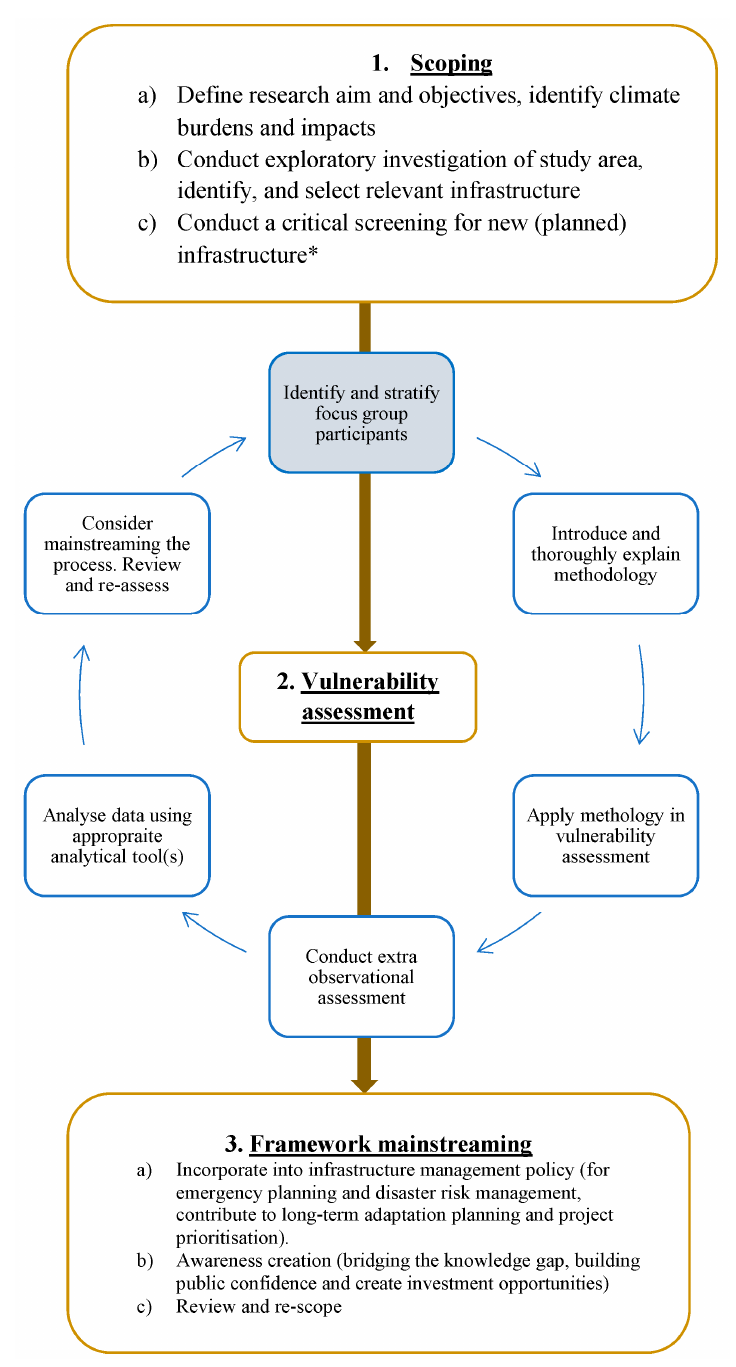
Figure 5. Overall schematic of multi-stakeholder framework for assessing the vulnerability of oil/gas infrastructure to climate change impact.